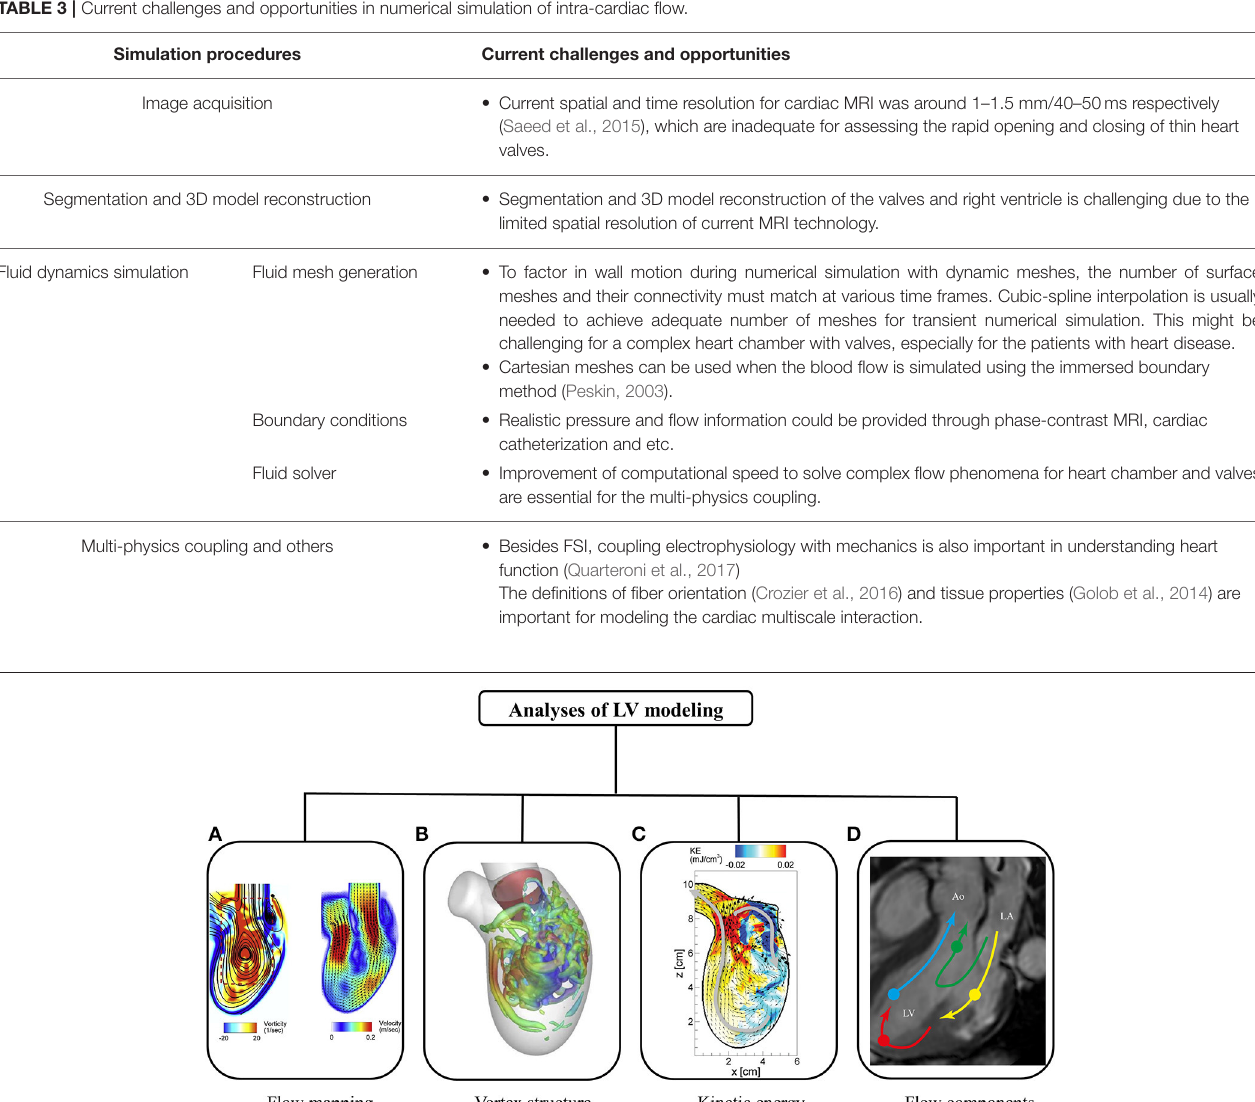
during atrial contraction, albeit weaker in terms of penetration distance. Both 2D flow mapping and 3D vortex structure provide quantitative analyses of LV